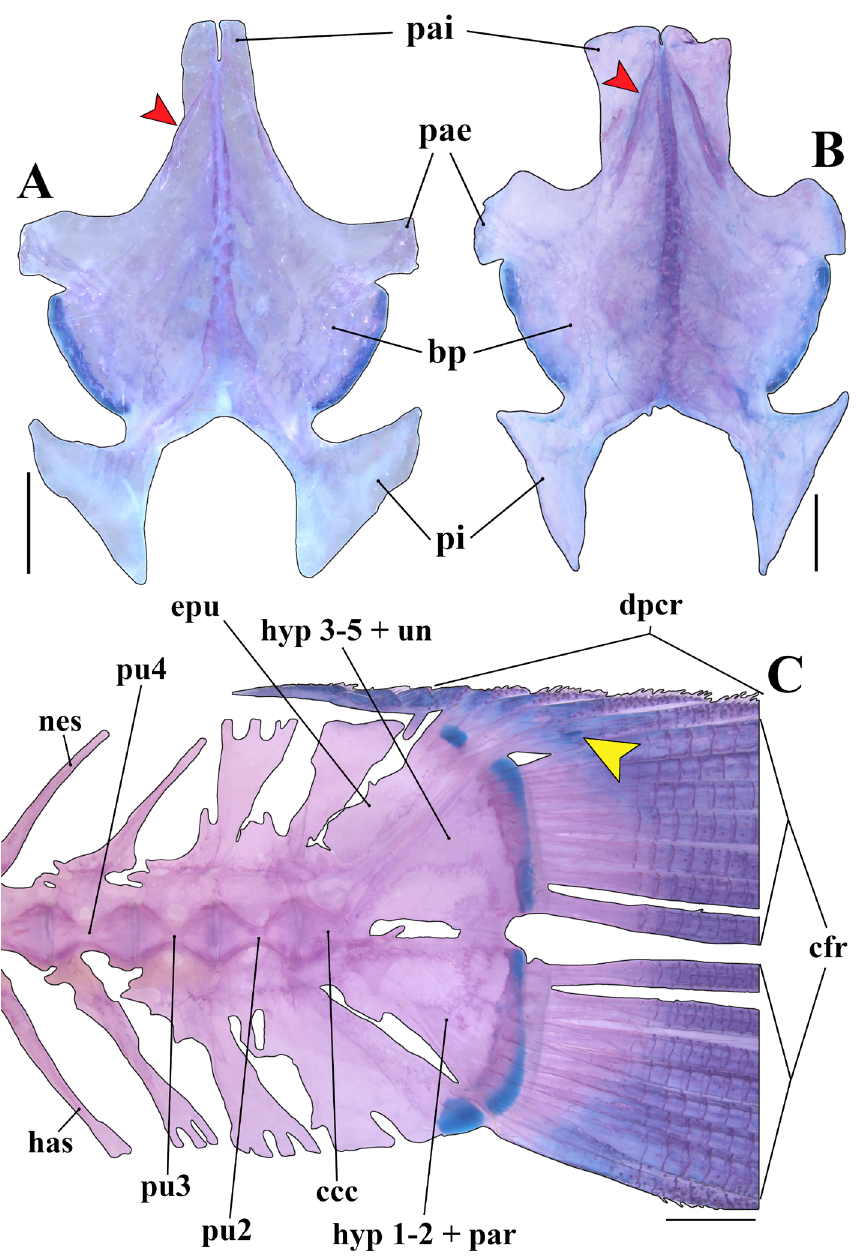
FIGURE 7 | Pelvic girdle and caudal skeleton in c&s paratypes of Corydoras maclurei (CITL 430). A. Anterior internal process of basipterygium slightly laterally expanded, and anterior external process not expanded posteriorly (38.2 mm SL); B. Anterior internal process of basipterygium conspicuously laterally expanded, and anterior external process slightly expanded posteriorly (47.8 mm SL); C . General morphology of caudal skeleton, showing the small cartilage (yellow arrow) between upper principal and procurrent caudal-fin rays (38.2 mm SL). Abbreviations: bp: basipterygium, ccc: compound